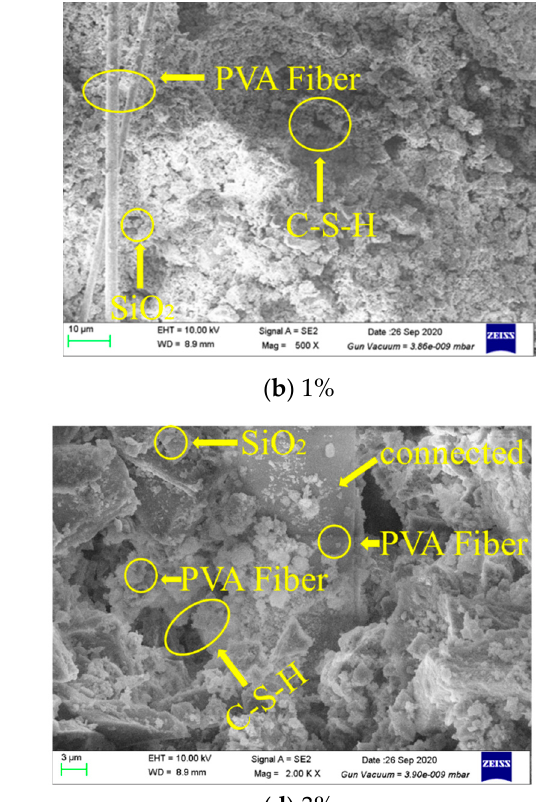
Figure 10. Synergistic mechanism of PVA fiber and NS. 5. Conclusions By changing the replacement ratio of mixed NS (0%, 0.5%, 1%, 2%, 3%, 4%) macro- scopically, we compared the NS recycled aggregate concrete with PVA fibers and the one without in terms of mechanical properties, the failure process, deformation and other characteristics; meanwhile, the microstructure changes were analyzed by the SEM tech- nique microscopically. In this way, we reached the following conclusions: (1) The addition of NS within a certain range greatly improves the mechanical prop- erties of the concrete. However, as the NS content exceeds a threshold, the performance of concrete no longer improves for the dispersion of nanoparticles.